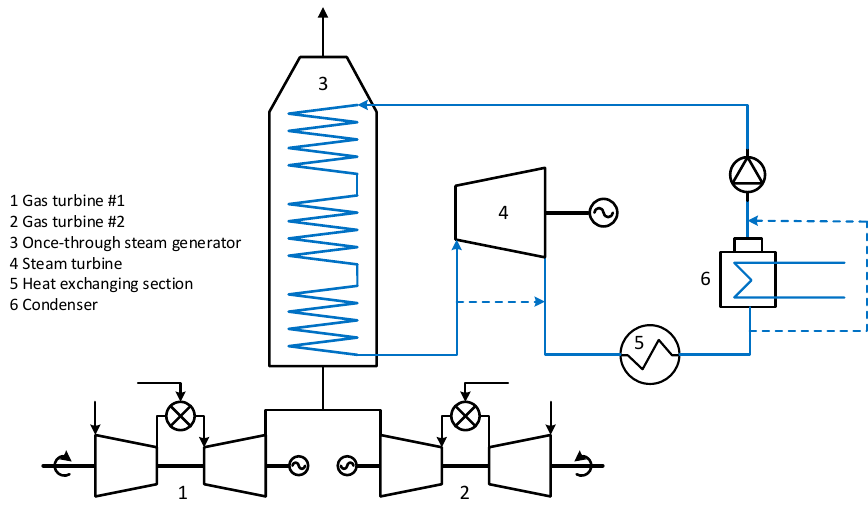
Figure 3. Layout of the backpressure steam turbine cycle.